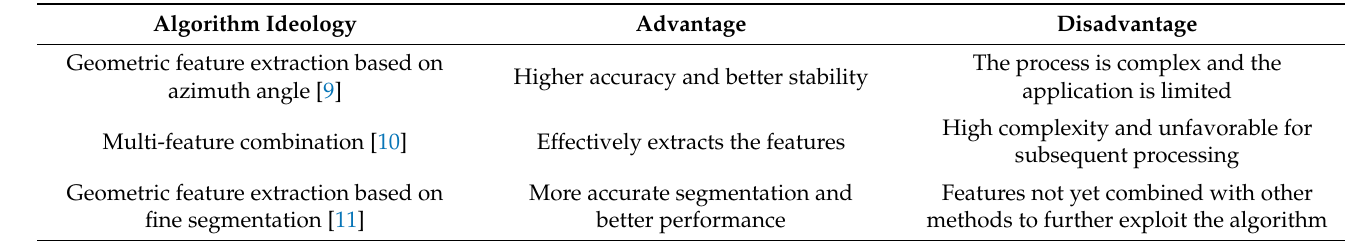
Table 1. A brief overview of the target detection algorithms based on structural features.